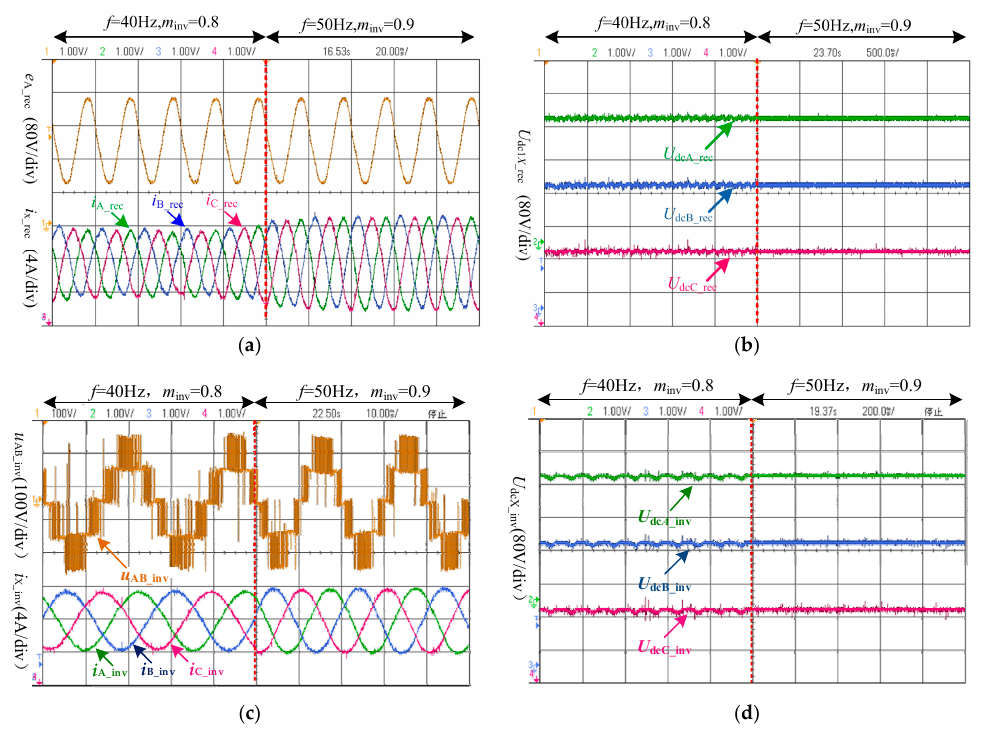
Figure 13. Experimental results of the multilevel converter in transient-state conditions; m inv changes from 0.8 to 0.9; ( a ) Input voltage-current waveforms, e A_rec and i X _rec ; ( b ) voltages of C X _rec ; ( c ) output voltage–current waveforms, u AB_inv and i X _inv ; ( d ) voltages of C X _inv . Energies 2018 , 11 , x FOR PEER REVIEW